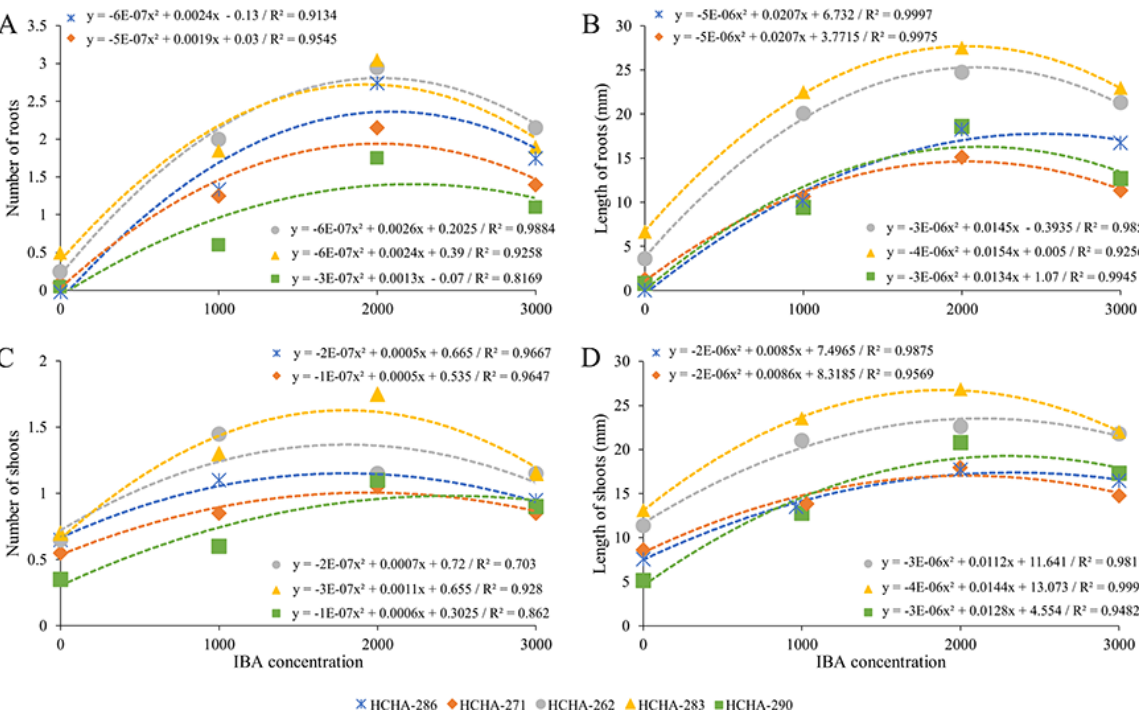
Figure 3 Polynomial regression graphs of the ( A ) number of roots, ( B ) length of roots, ( C ) number of shoots and ( D ) length of shoots in wild blueberry accessions treated with increasing concentrations of indole-3-butyric acid